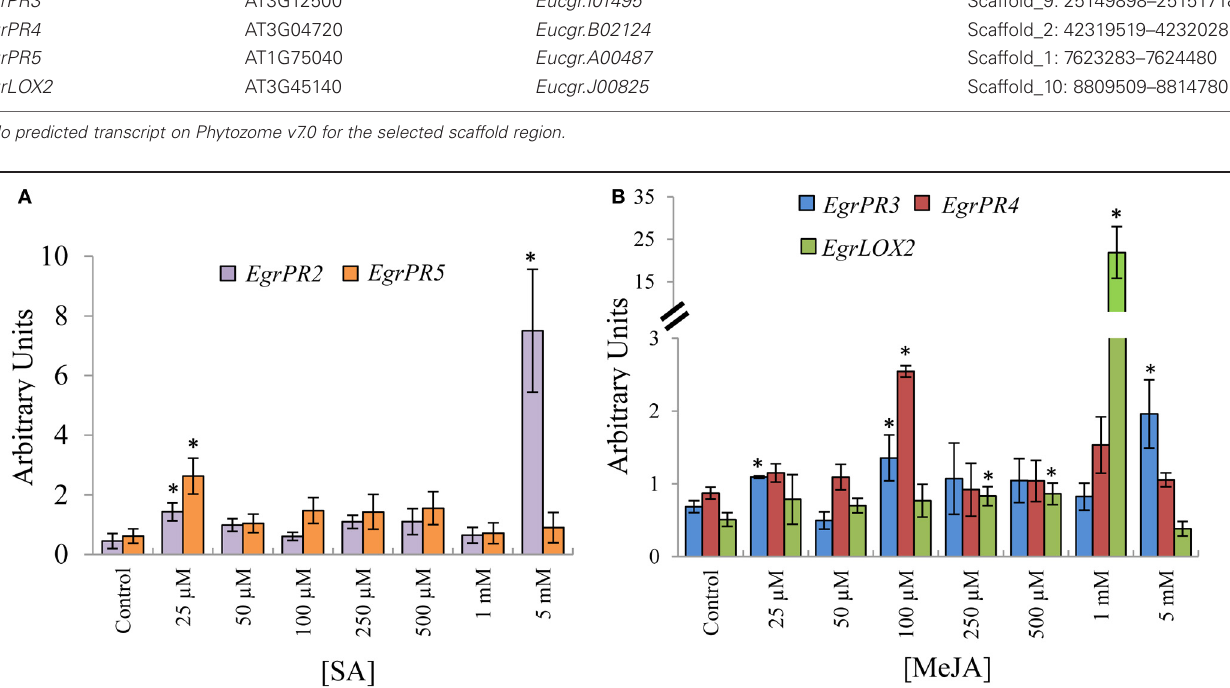
arbitrary units. The x-axis shows the respective concentration range that was applied to the aerial parts of E. grandis plants. Error bars show the standard error of the mean of the biological replicates ( n = 3) sampled after 24hpt. Significance, indicated by ∗ , is relative to the control for each target and was calculated by the Kruskal–Wallis test ( p < 0 .